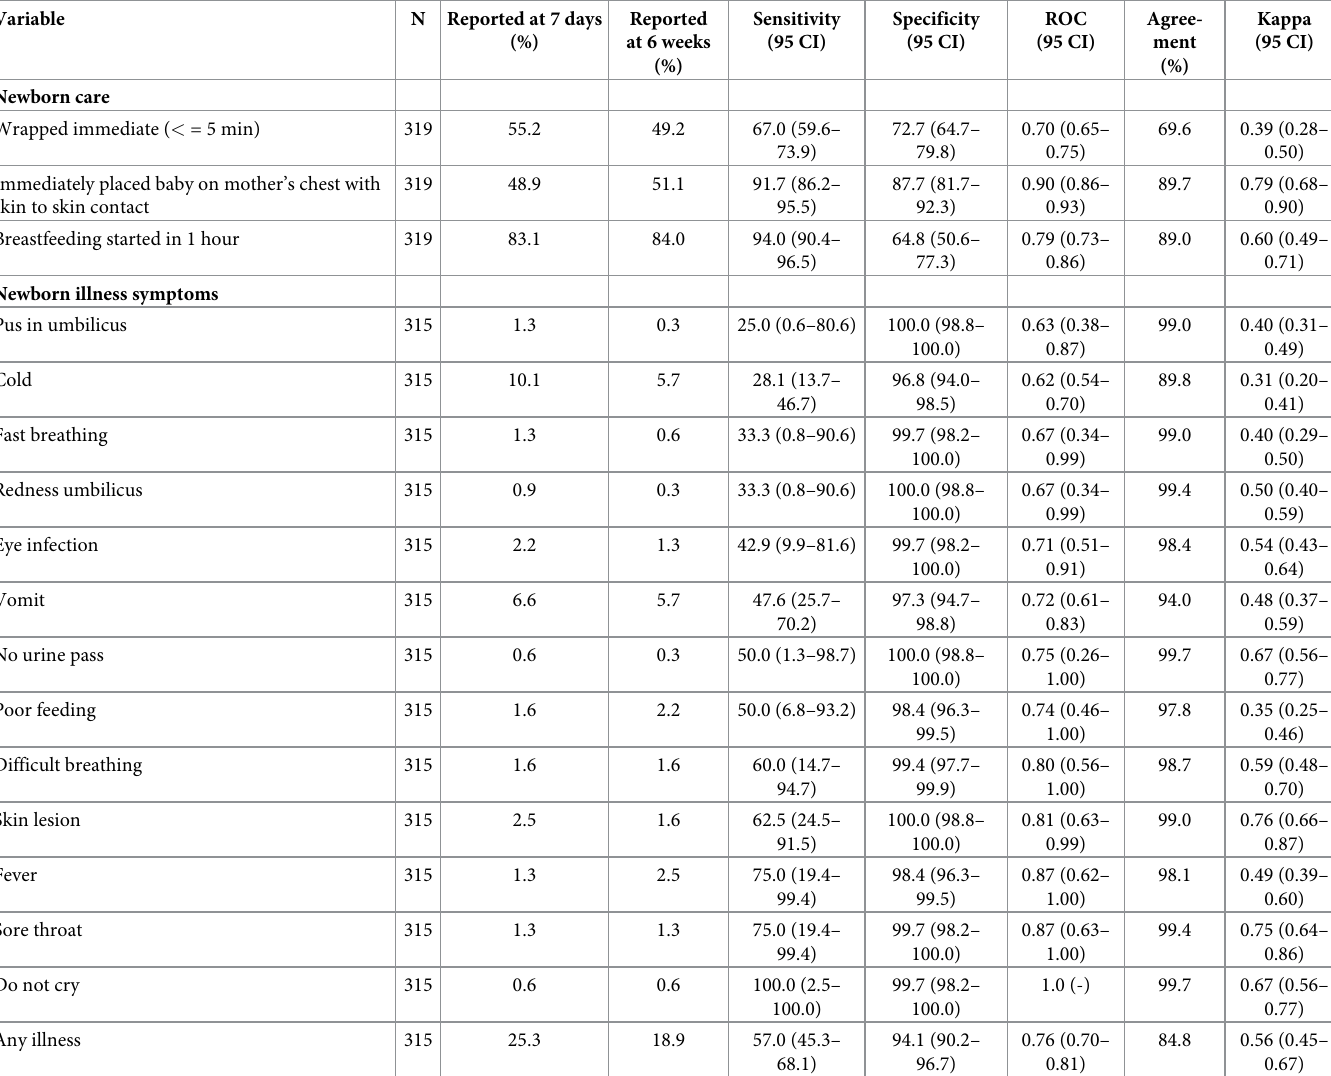
Table 6. Agreement diagnostics for select neonatal interventions and symptoms reported at 7-day and 6-week follow-up visits.